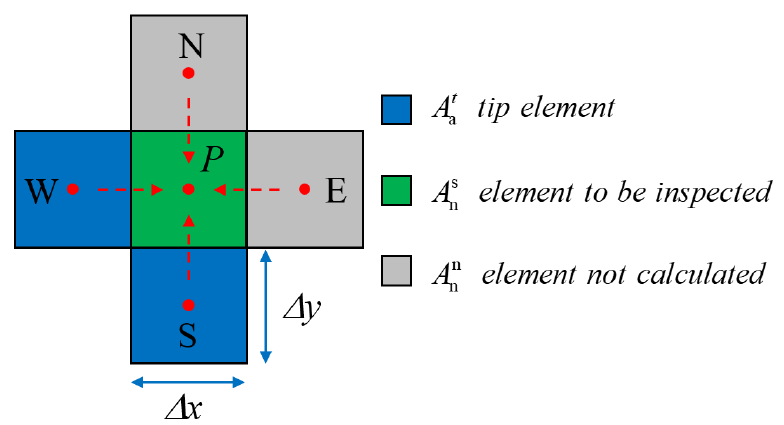
Figure 1. Schematic diagram of element activation and calculation.